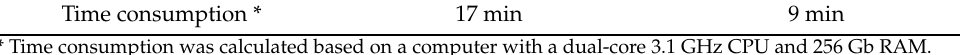
Figure 13. Comparison of results between FEM and the C-ICs methods for a curved shaft contact with the bearing when δ max = 0.05 mm.